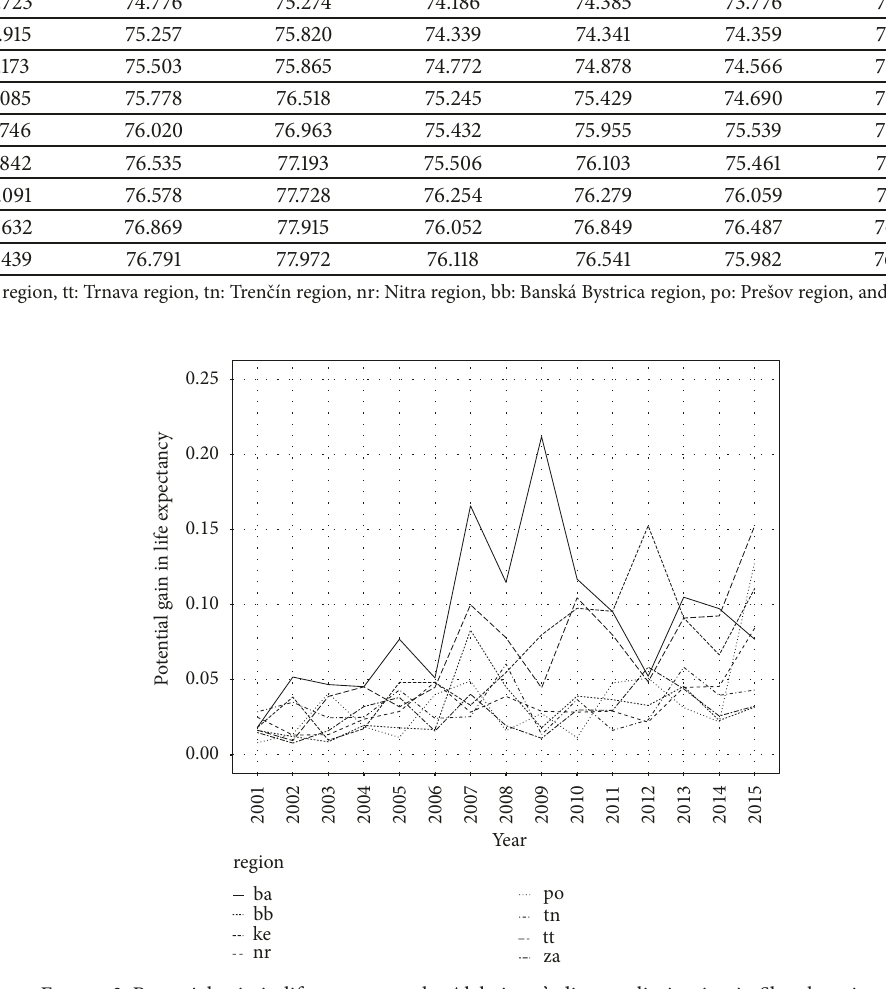
regions are located in the western part of the Slovak